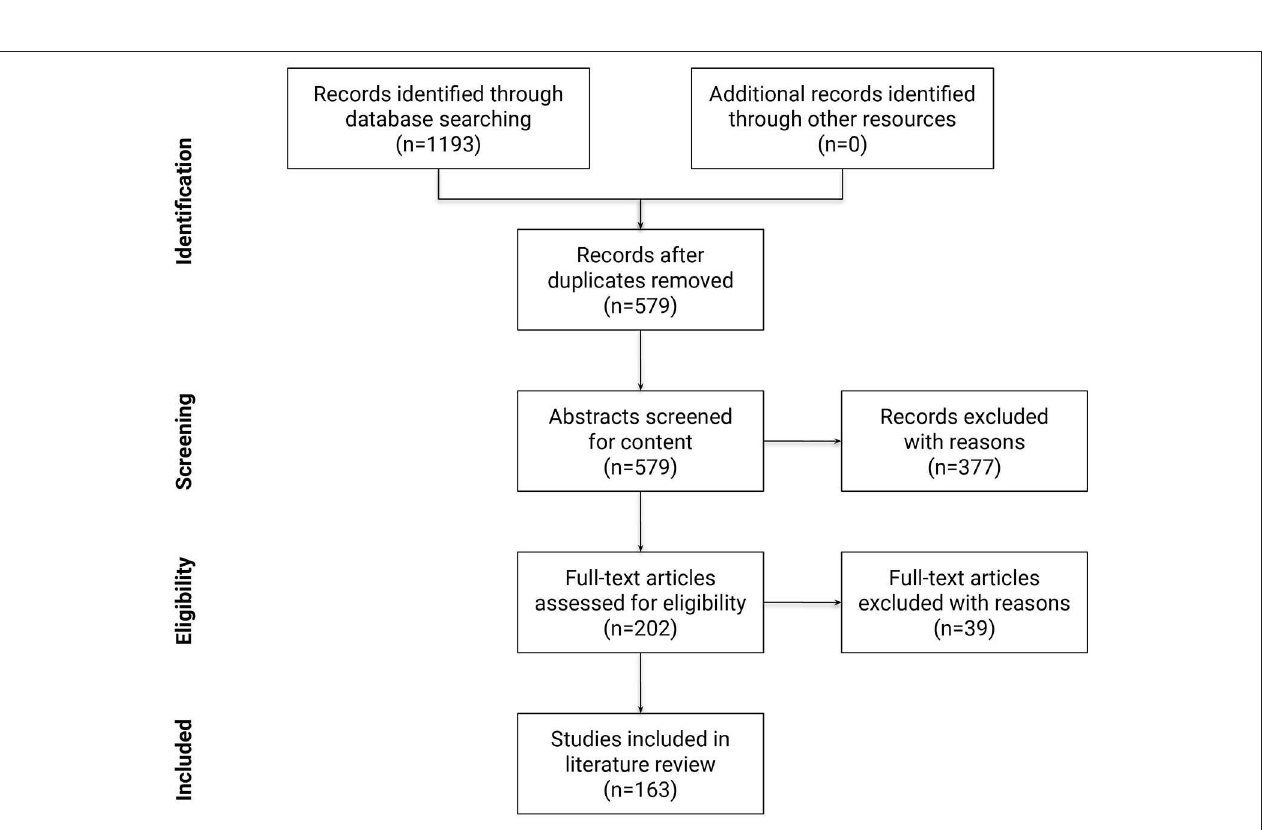
FIGURE 6 | Flow diagram of the methodology and selection processes used in this review. It follows the guidelines of PRISMA (Moher et al., 2010).